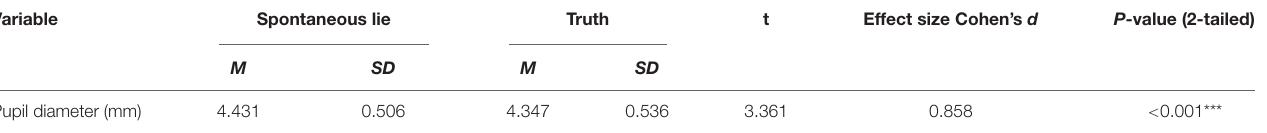
FIGURE 3 | The experiment procedure of Study 2. TABLE 4 | The analysis of pupil size in Study